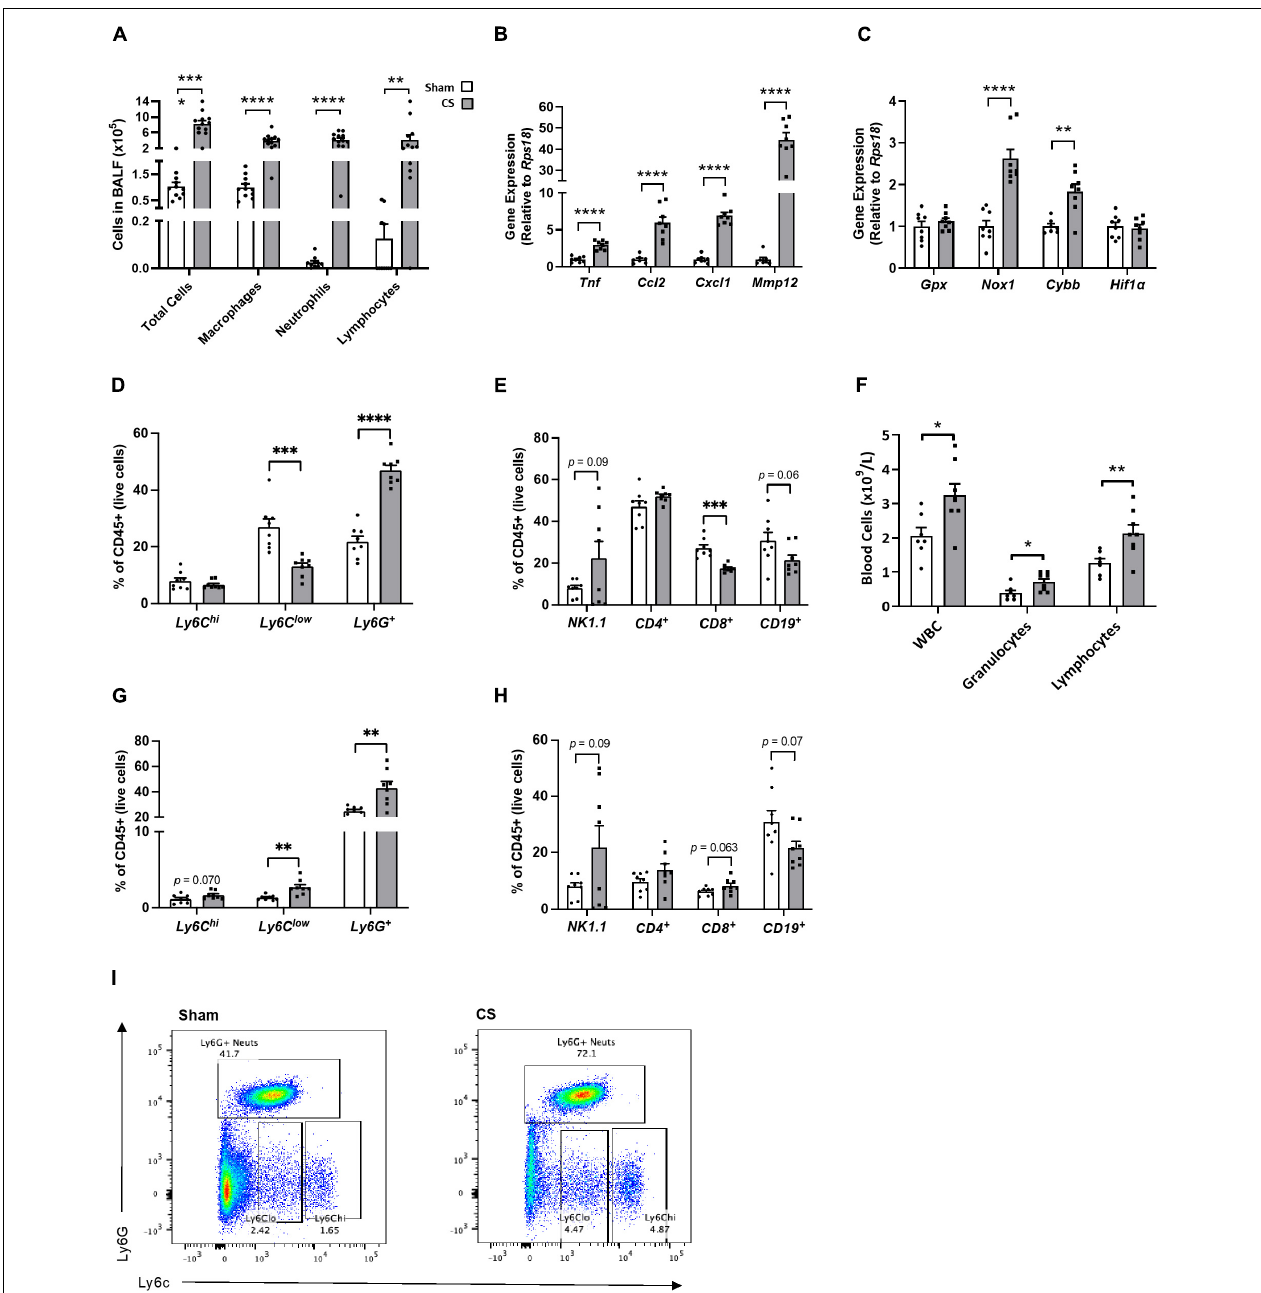
FIGURE 3 | Chronic CS exposure causes lung and systemic inflammation. Mice were exposed to sham or CS (9 cigarettes/day, 5 days/week for 24 weeks). (A) Differential counts in the bronchoalveolar lavage fluid (BALF). (B) Inflammatory and protease mRNA expression in the lung. (C) Oxidative stress mRNA expression in the lung. (D) Percentage of innate immune cells in the lungs. (E) Percentage of adaptive immune cells in lungs. (F) Differential blood cell counts to assess leukocyte, granulocyte, and lymphocyte levels. (G) Percentage of innate immune cells in the blood. (H) Percentage of adaptive immune cells in blood. (I) Flow cytometric lung representative images. Data were analyzed by Student’s t -test and expressed as mean + SEM with significance being represented as; * p < 0.05, ** p < 0.01, *** p < 0.001, and **** p < 0.0001. n =